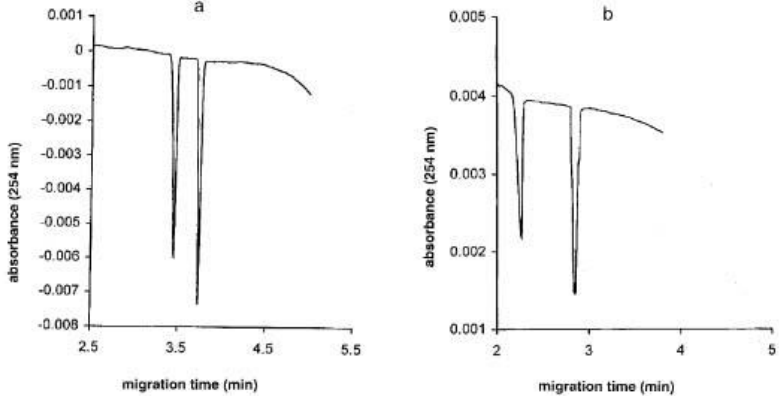
Figure 3. Enantiomeric separation of carboxymethylcysteine and N -acetamido-carboxymethylcysteine ( a ) using 10 mM vancomycin as CS; ( b ) using 1 mM vancomycin as CS. The figure is reproduced from Fanali et al. [32] with permission from Wiley.